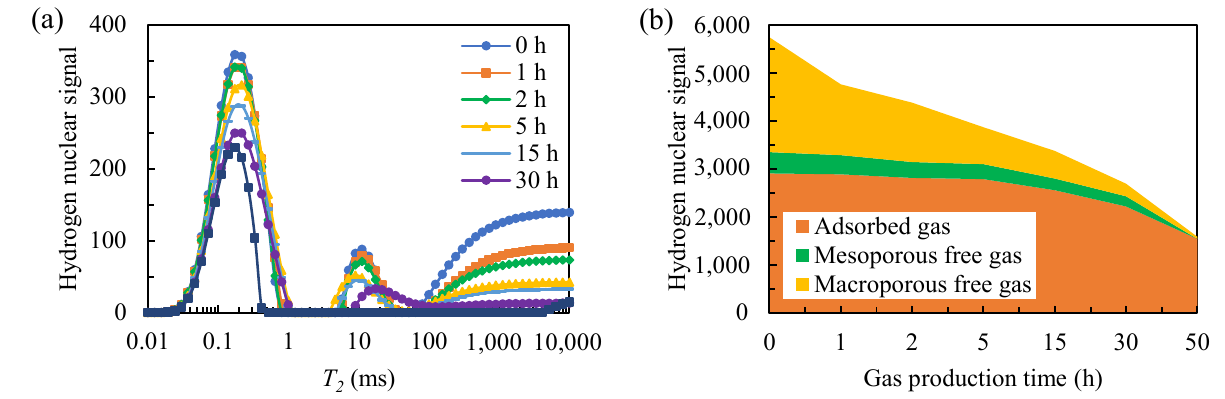
Figure 5. ( a ) T 2 spectrum of shale samples and ( b ) signals of different methane during gas production. Most of the gas produced early in gas production is the free gas in the macropores. At the late stage of gas production, the free gas in the mesopores and the adsorbed gas on the pore wall are produced.